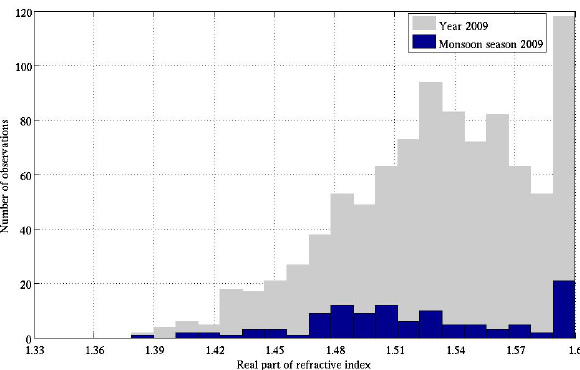
Fig. 12. Histogram of (real part) refractive index from Gual Pahari sunphotometer measurements during